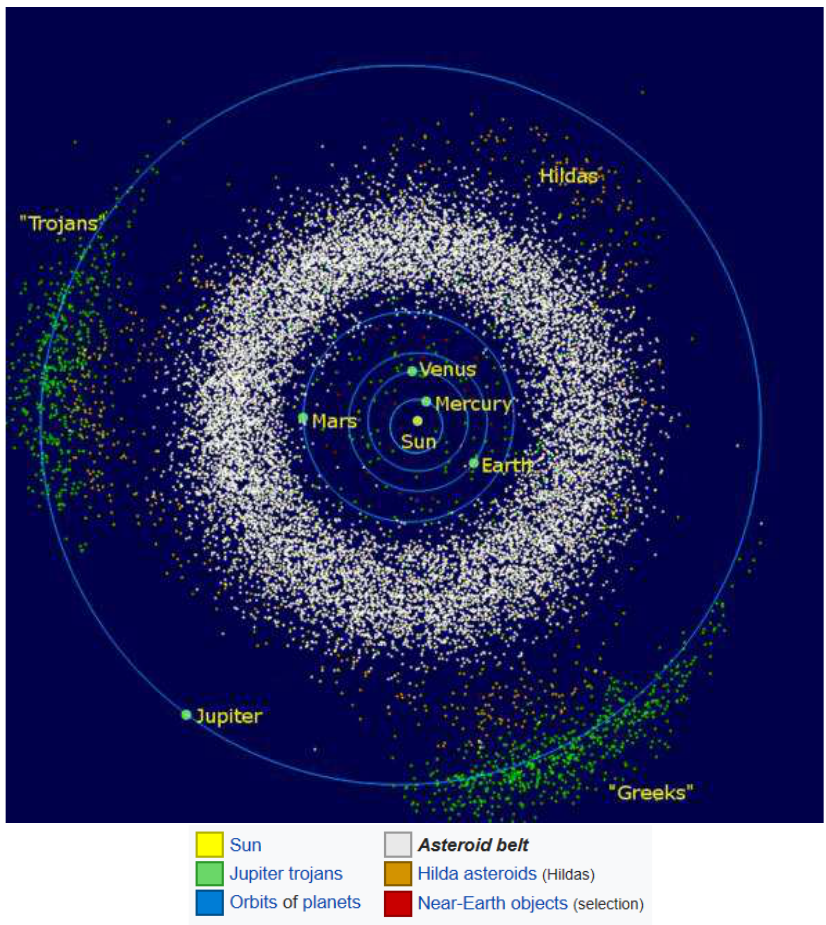
Fig. 1 The asteroids of the inner Solar System and Jupiter (Color figure